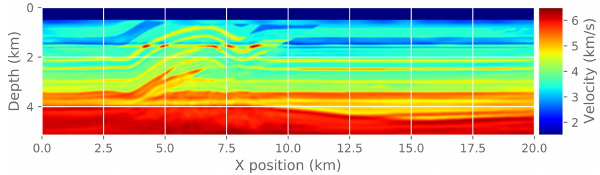
Figure 18. Final image after running FWI atol = 10 − 2 . It is visu- ally indistinguishable from the reference solution in Fig.